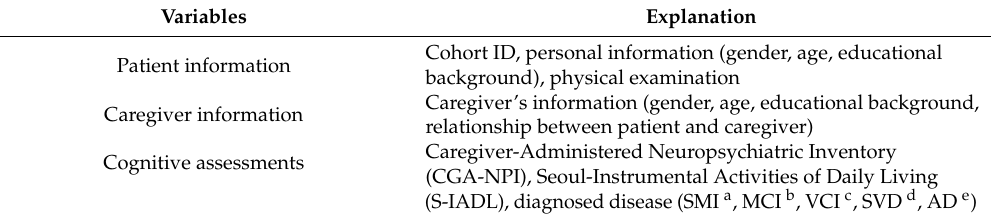
Table 2. Data components included in Clinical Research Center for Dementia of South Korea (CREDOS). Reproduced with permission from the authors of [10]; published by ACM,